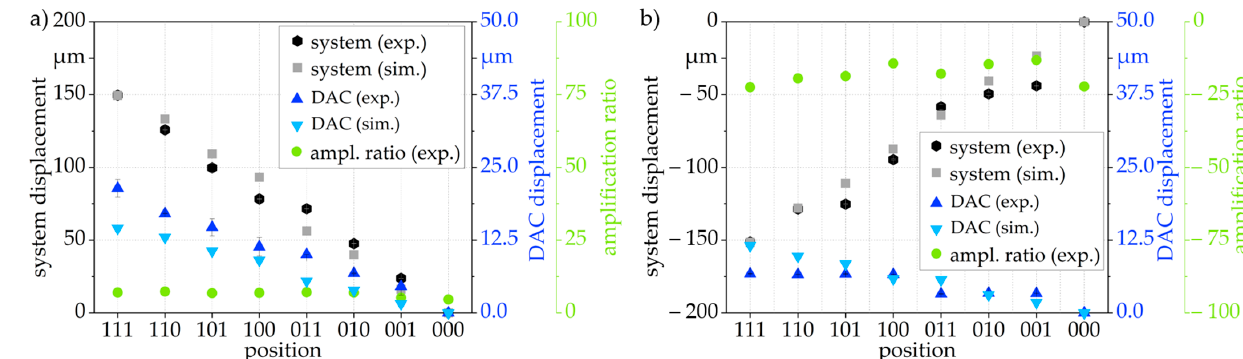
Figure 13. Simulative and experimental displacement and the resulting amplification ratio by displacing the systems in logical order from the 111 to 000 positions, including all the intermediate steps, with a switching time of 2 s for ( a ) system 1 at 60 V and ( b ) system 2 at 75 V (each experiment was repeated three times).